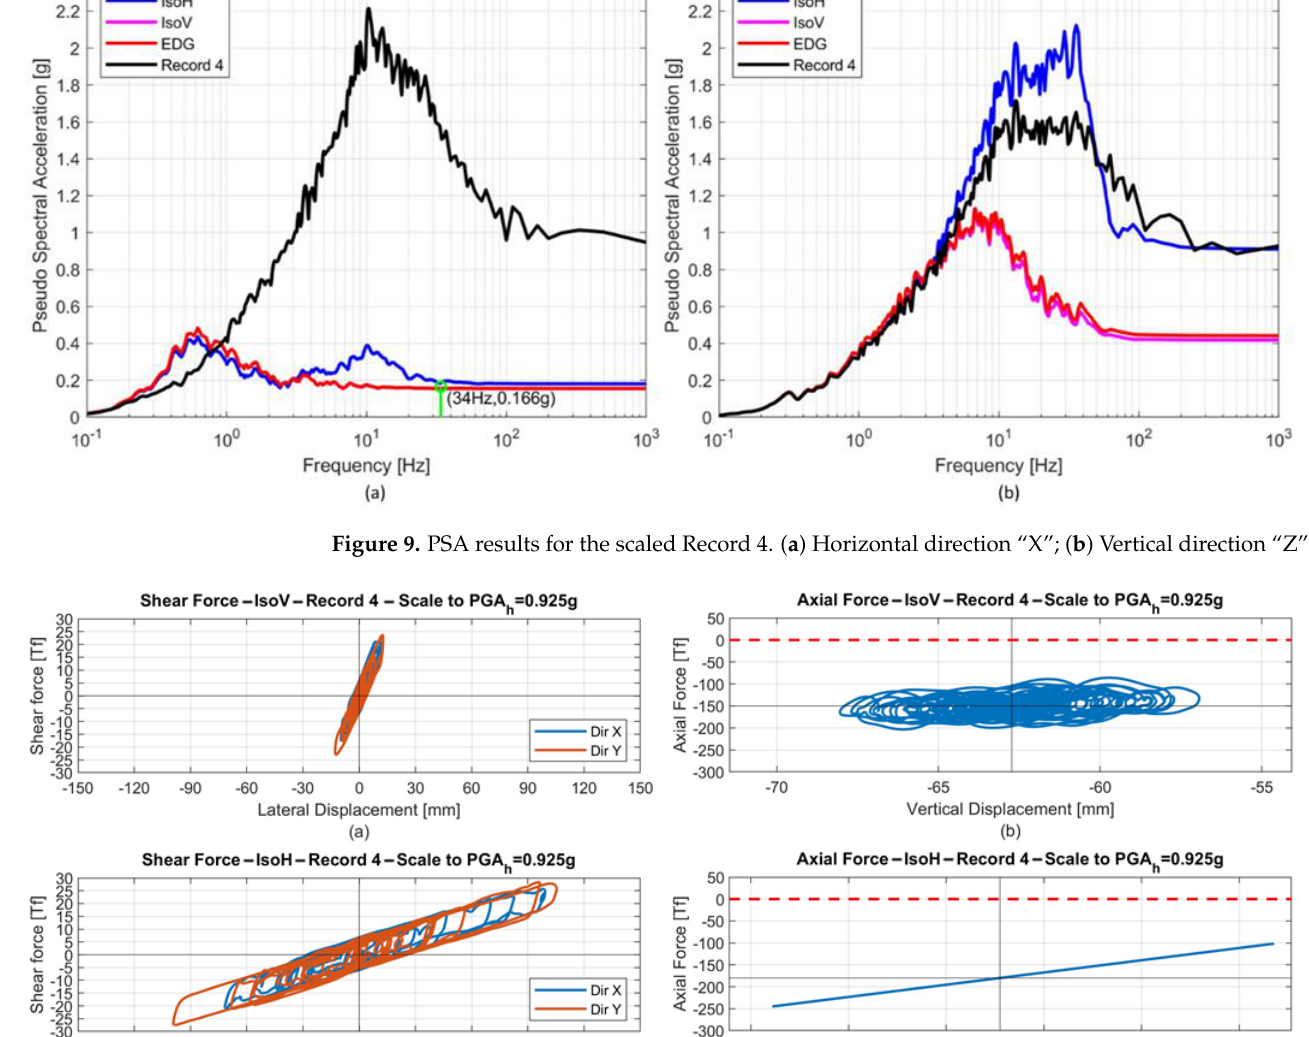
Figure 9. PSA results for the scaled Record 4. ( a ) Horizontal direction “X”; ( b ) Vertical direction “Z”.